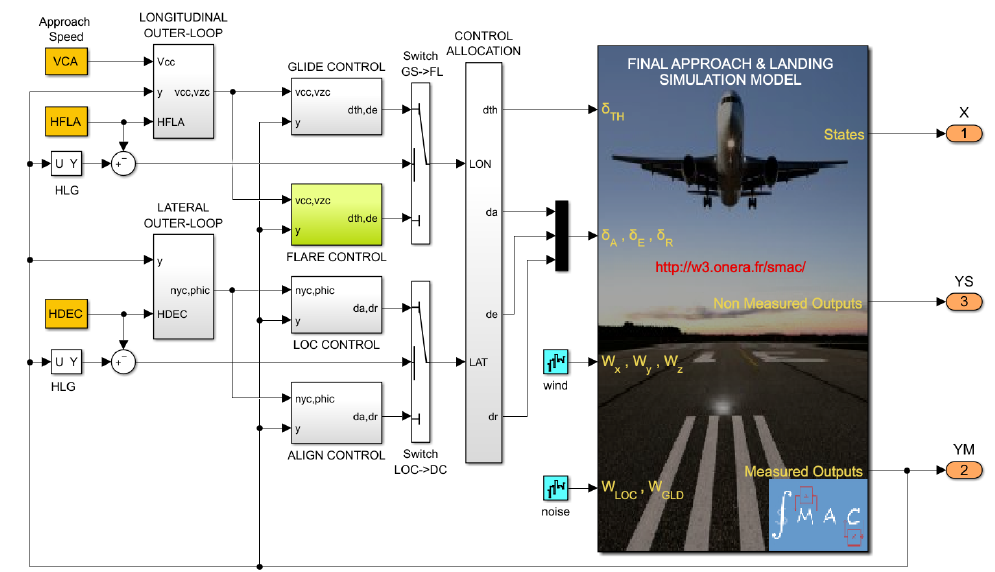
Figure 5. Nonlinear closed-loop simulation model.